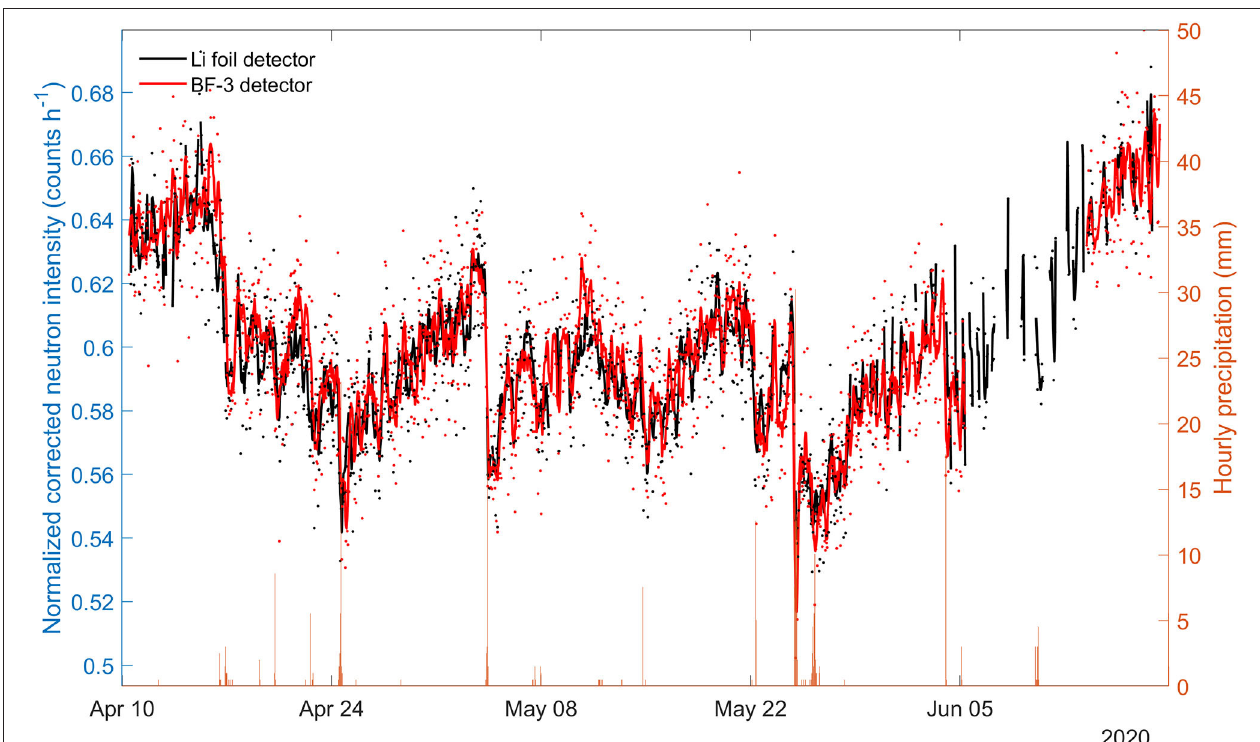
FIGURE 6 | Temporal dynamics of normalized (N/N 0 ) corrected cosmic-ray neutron counts from the Li foil and BF-3 systems from 10 Apr 2020 to 18 Jun 2020 in a cropped field located in the Konza Prairie Biological Station near Manhattan, KS, USA. The point-cloud represents hourly neutron intensity for each system and the lines represent the 11h moving Savitzky-Golay filter (polynomial degree 3). Hourly precipitation totals are shown as vertical